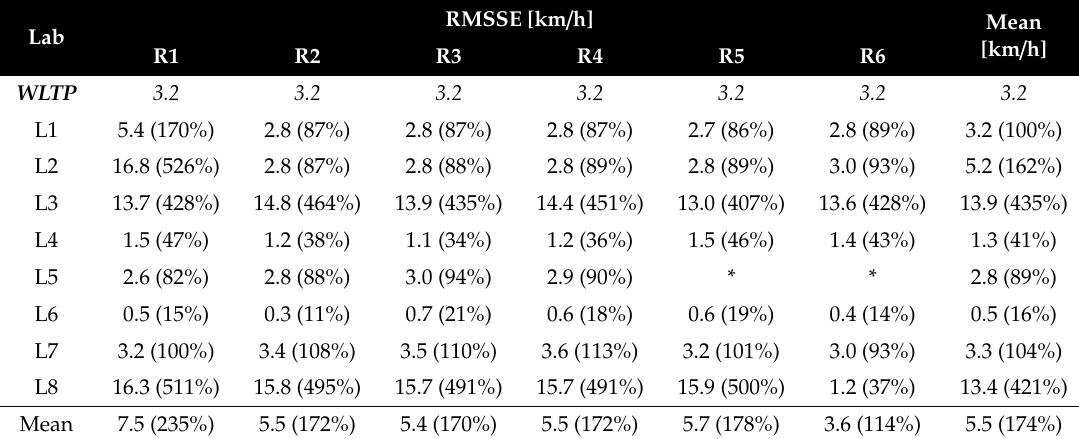
Table 4. Summary of RMSSE and % RMSSE values for T1 for all labs—mean values include only the actual lab results. (*) denotes missing